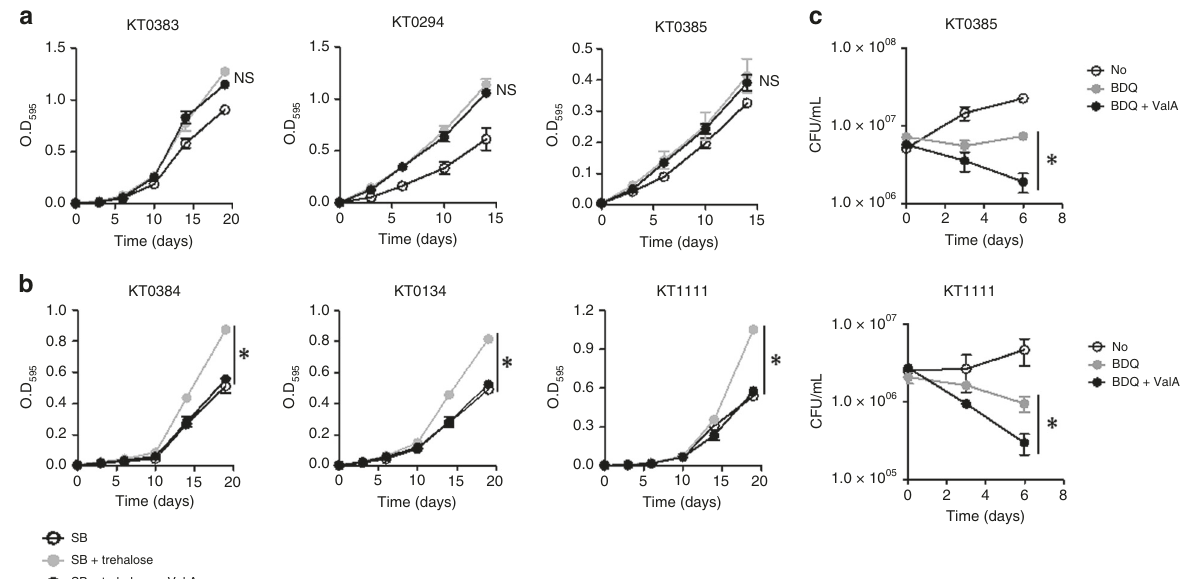
Fig. 6 XDR- and TDR-TB clinical isolates use the trehalose-catalytic shift for survival. a The growth of drug-sensitive TB isolates (KT0294, KT0383, and KT0385) in m7H9 media containing 10 mM sodium butyrate (SB) was enhanced by supplementing with 20 mM trehalose, but not restored by treating with 200 µ M validamycin A (Val A). b The growth of drug-resistant isolates (XDR-TB, KT0134, and KT0384; TDR-TB, KT1111) in m7H9 media containing 10 mM SB was enhanced by supplementing with 20 mM trehalose, and completely restored to trehalose-untreated levels following treatment with 200 µ M Val A. c Chemical inhibition of TreS as an adjunctive therapeutic strategy to boost BDQ-mediated antimicrobial effect on drug-sensitive and drug-resistant clinical isolates. All values are the average of biological triplicates ±s.e.m. * P < 0.01; NS, not signi fi cant by ANOVA between SB + trehalose and SB + trehalose + Val A ( a ) and between BDQ and BDQ + Val A ( b ) with Bonferroni post-test